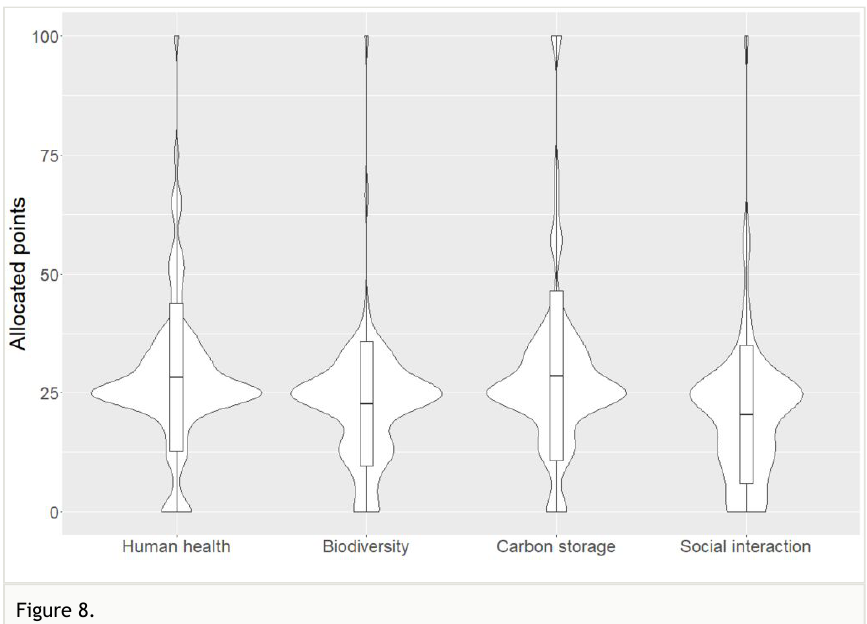
Figure 8. Mean standard deviation and distribution of assigned weights per